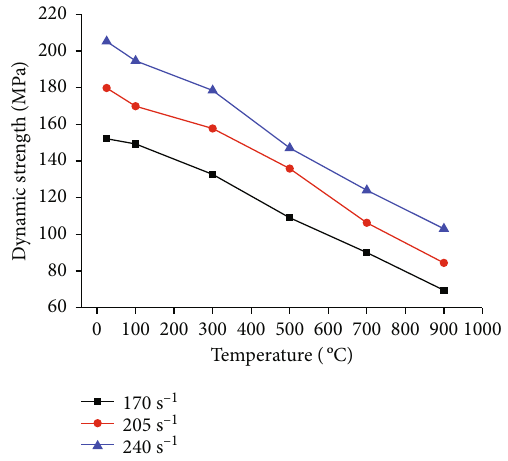
Figure 4: Variation in dynamic strength of deep sandstone with strain rate and